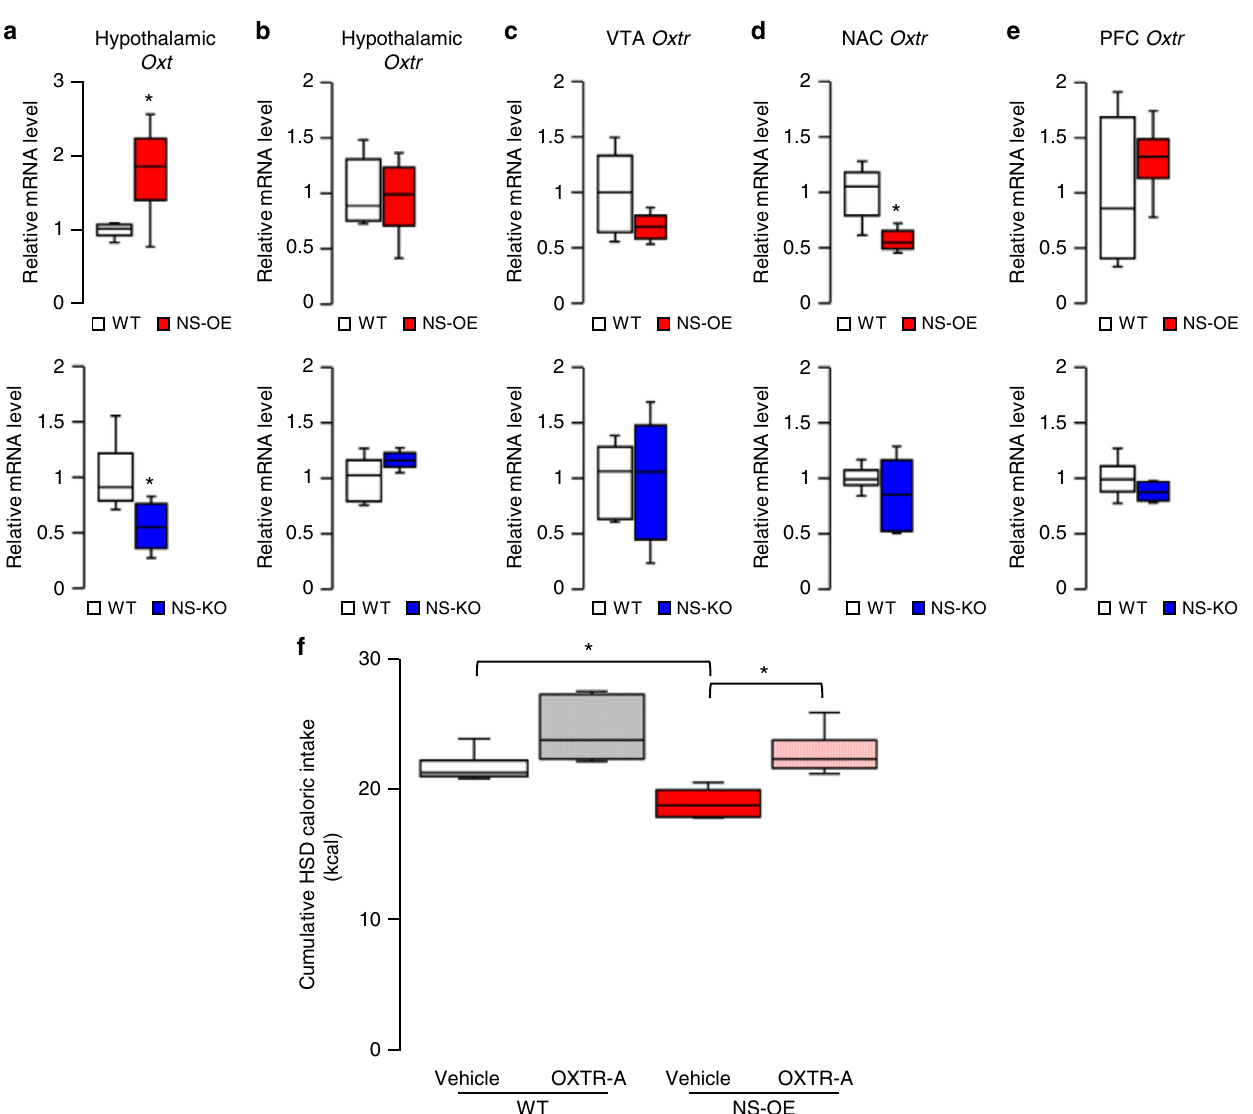
Fig. 2 Neuronal SIRT1 regulates sucrose preference through Oxt. a – e Relative RNA expression levels, for NS-OE (red) and NS-KO (blue) mice; Oxt expression in the hypothalamus ( a ); Oxtr expression in the hypothalamus ( b ), ventral tegmental (VTA) ( c ), nucleus accumbens (NAc) ( d ) and prefrontal cortex (PFC) ( e ) ( n = 6 per group). f The effect of an IP injection of Oxt receptor antagonist OXTR-A (L-368,899) on HSD intake in NS-OE and littermate control mice ( n = 5 per group). Data are shown as box and whisker plots (centre line, median; box limits, upper and lower quartiles; whiskers, the minimum and maximum value of a data set). * p < 0.05. See also Supplementary Fig.